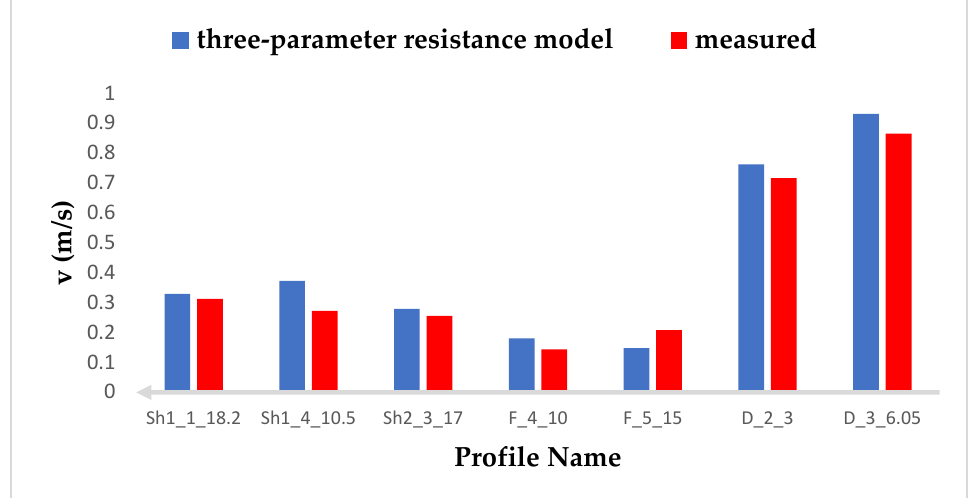
Figure 12. Comparison between the velocity calculated from the model with the measured velocity.